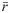
Mean correlation coefficients r¯ between the original clean EEG signals and EEG signals with suppressed muscular artifacts as a function of subspace dimension L for 111, 10/10 and 10/20 electrode systems.